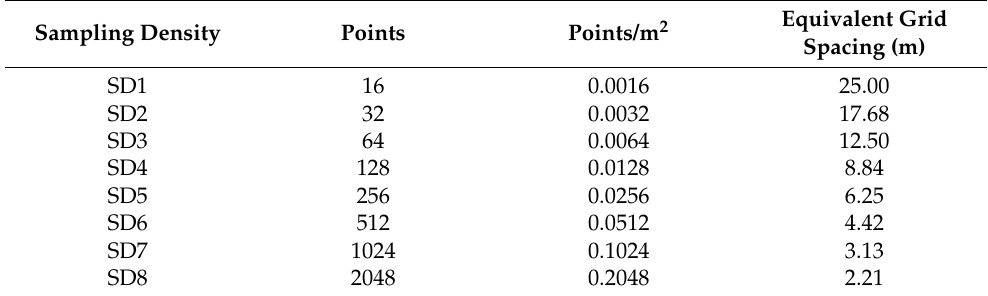
Table 1. Tested sampling densities with their corresponding equivalent grid spacing. Sampling